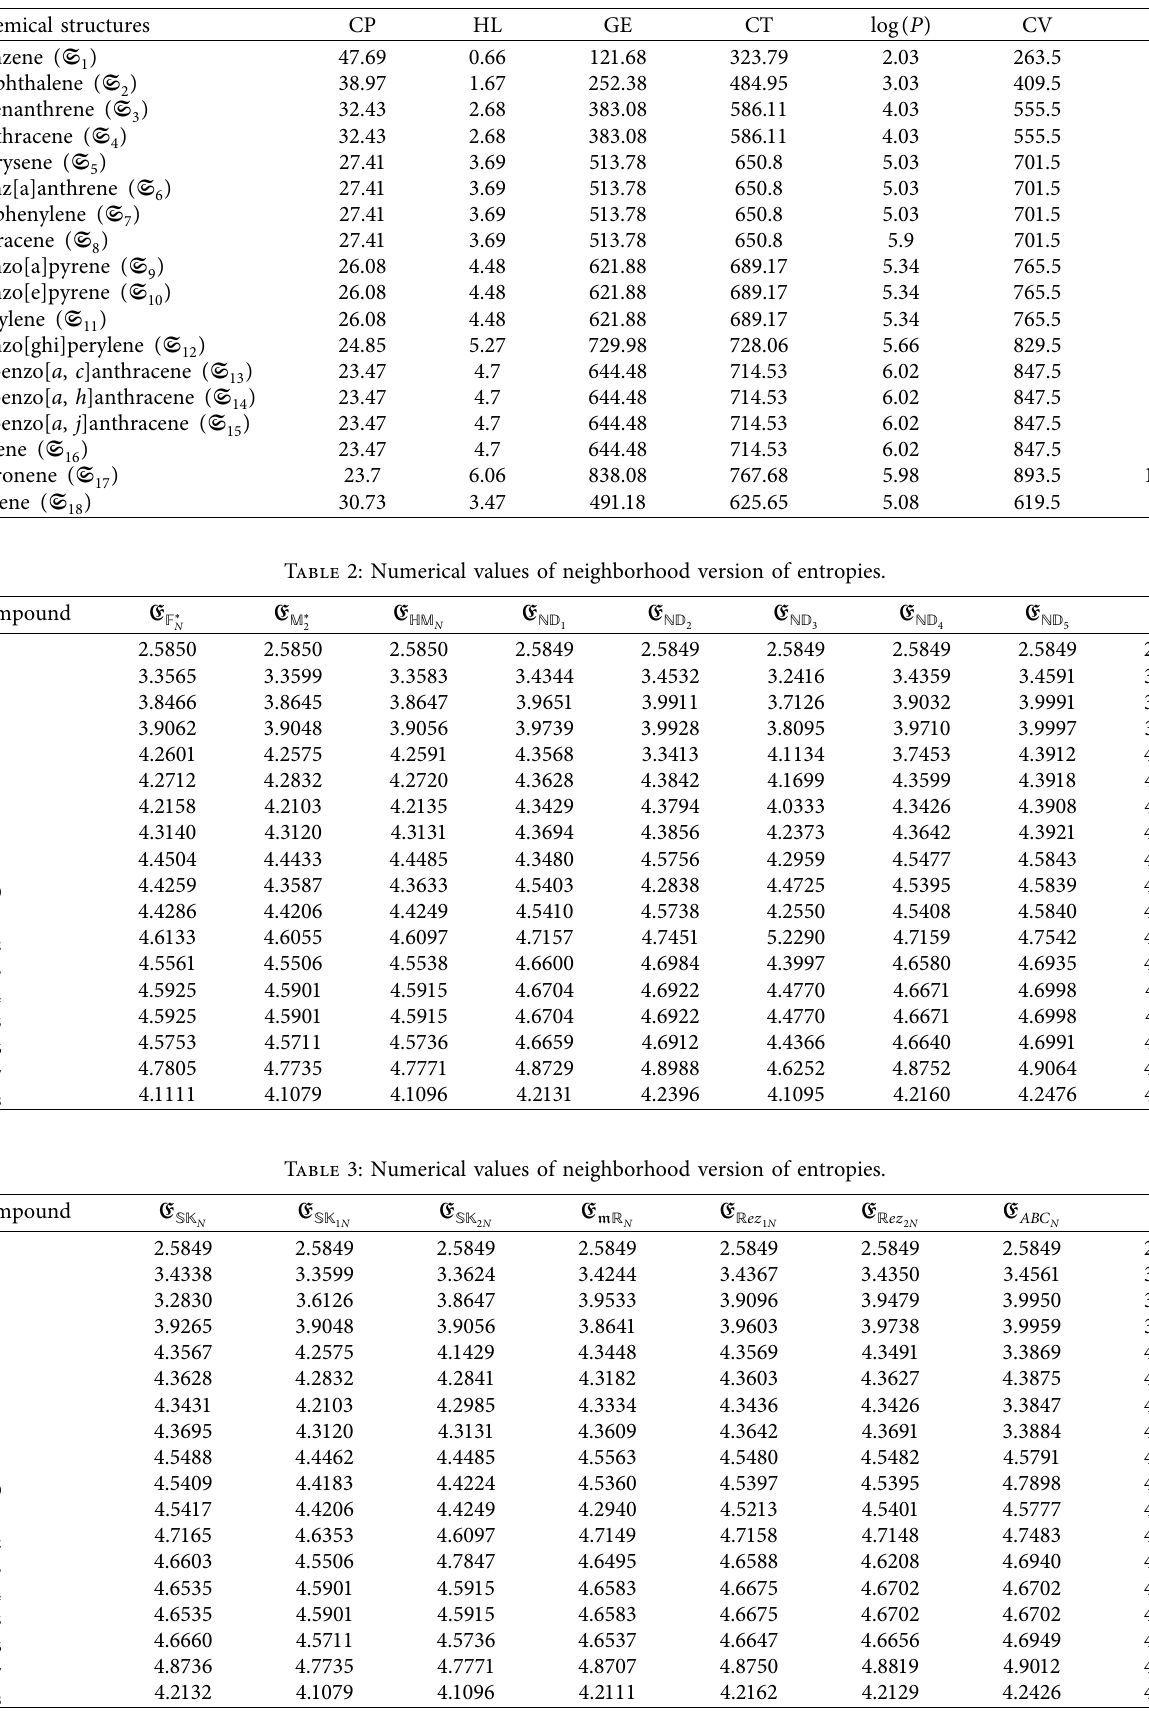
Table 1: The physical characteristics of benzene derivatives.